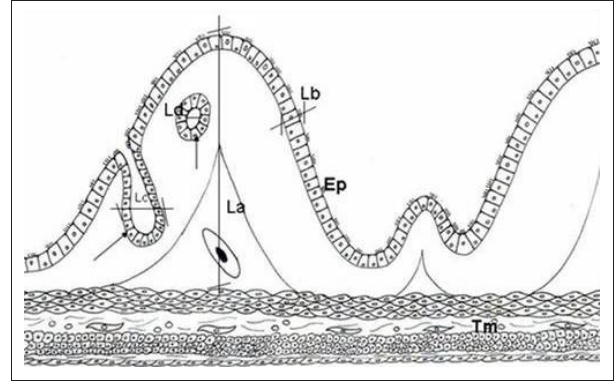
FIGURE 1: Schematic drawing of the oviductal mucosa of the Japanese quail.